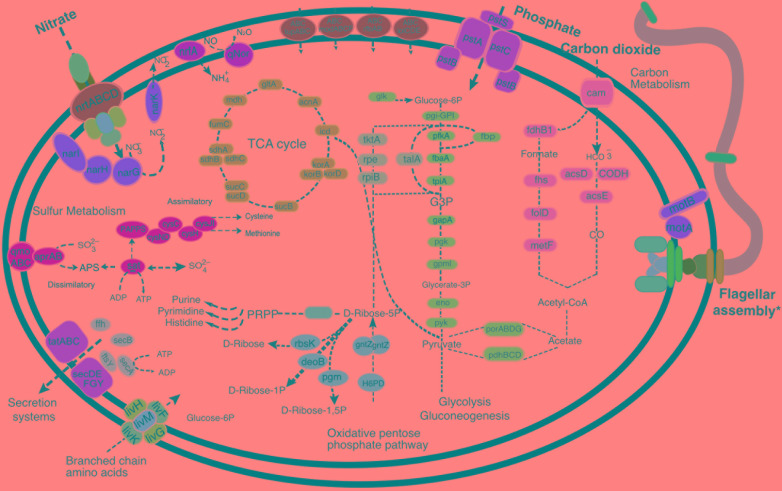
Metabolic reconstruction of the typical “Candidatus Abyssubacteria” cell. Key metabolic predictions and novel features identified in “Ca. Abyssubacteria” genomes, with full gene information available in Supplementary Data File 3. ∗Full annotations and machinery for motility and flagellar assembly can be found in Supplementary Figure 2.